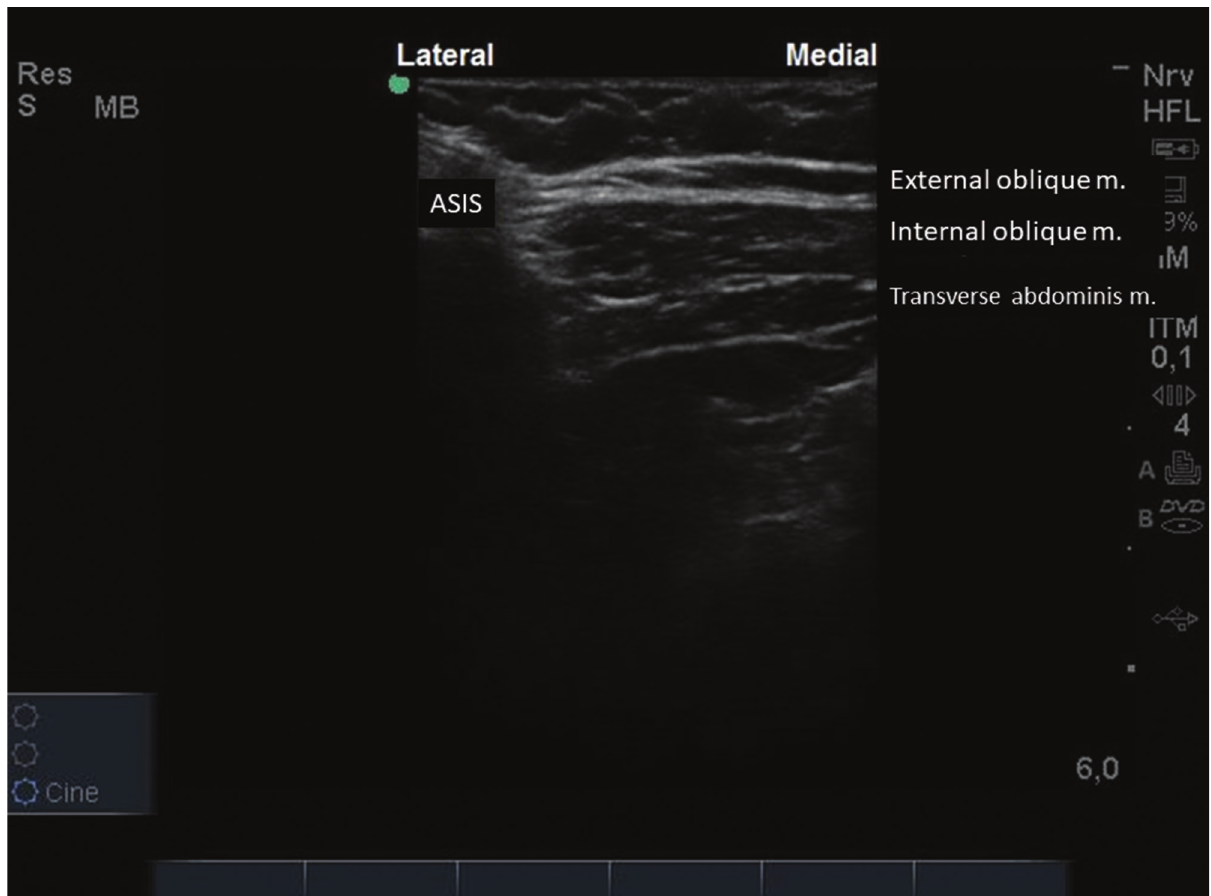
Figure 13 - ASIS (anterior superior iliac spine) laterally, and muscles of the abdominal wall